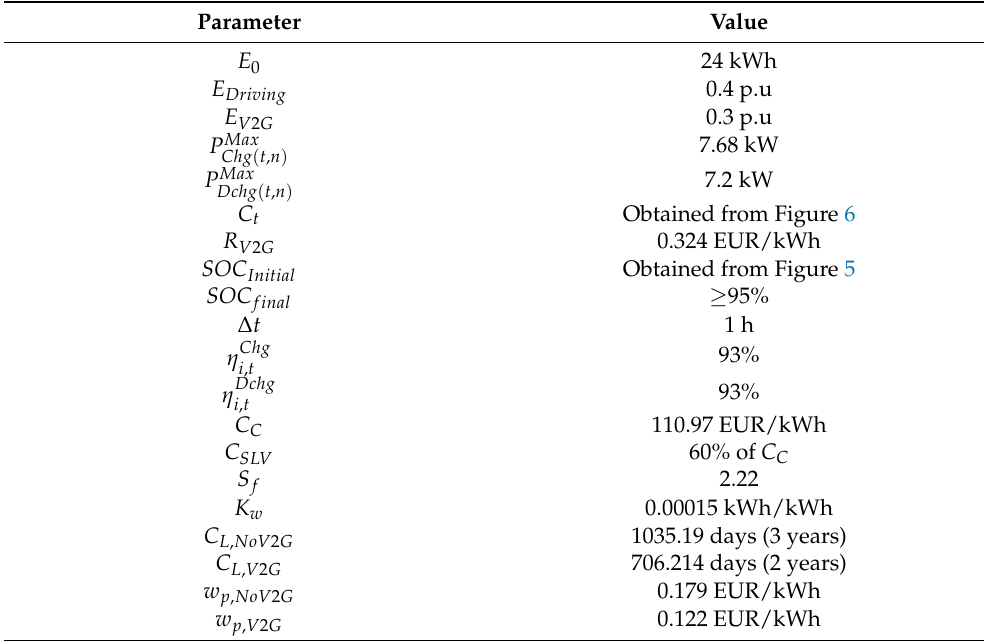
Figure 8. Schedule of ( a ) active power for EVs for different methods; ( b ) reactive power for EVs for different methods under 30% EV penetration.